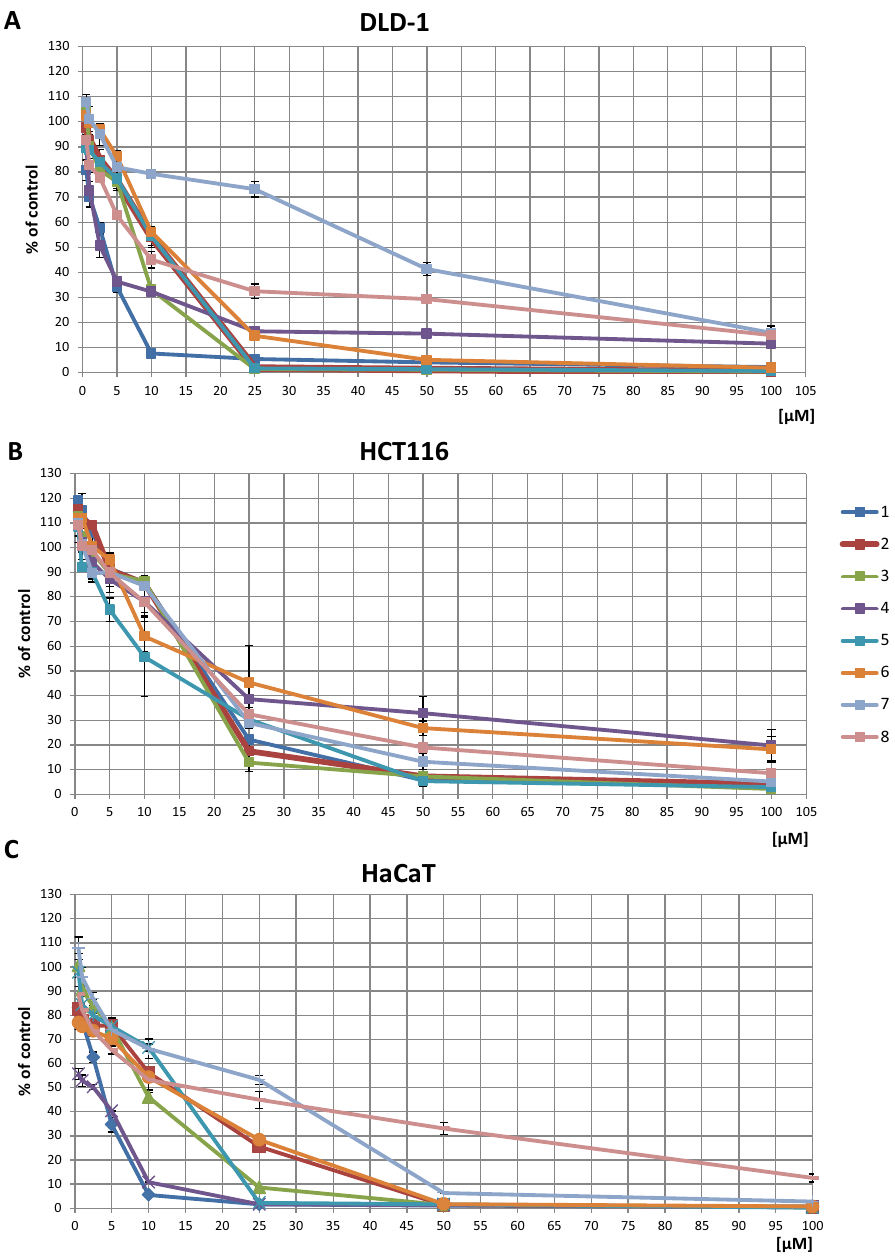
Figure 1. The effect of thioderivative chalcones on the viability of DLD-1 ( A ), HCT116 ( B ) and HaCaT (C) cells. Mean values ± SEM from three independent experiments are